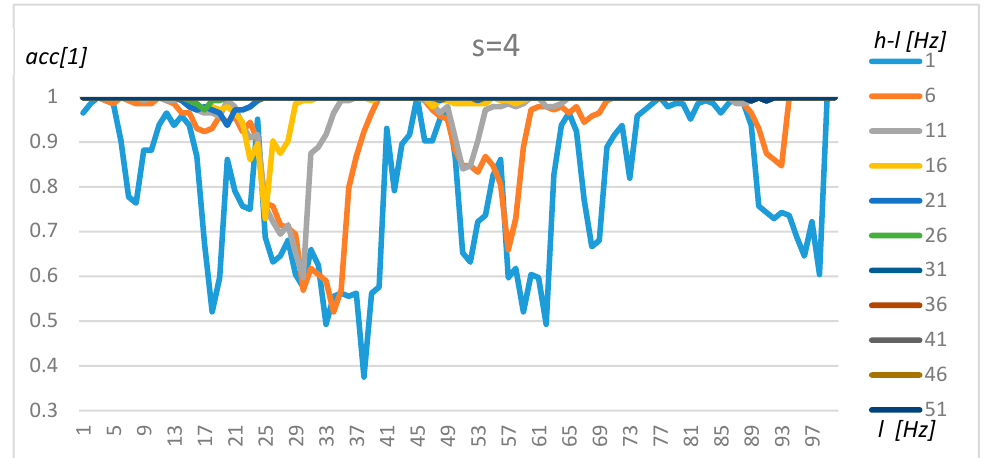
Figure 8. The accuracy value for Transformer 1, s = 4, and various l and h parameters.